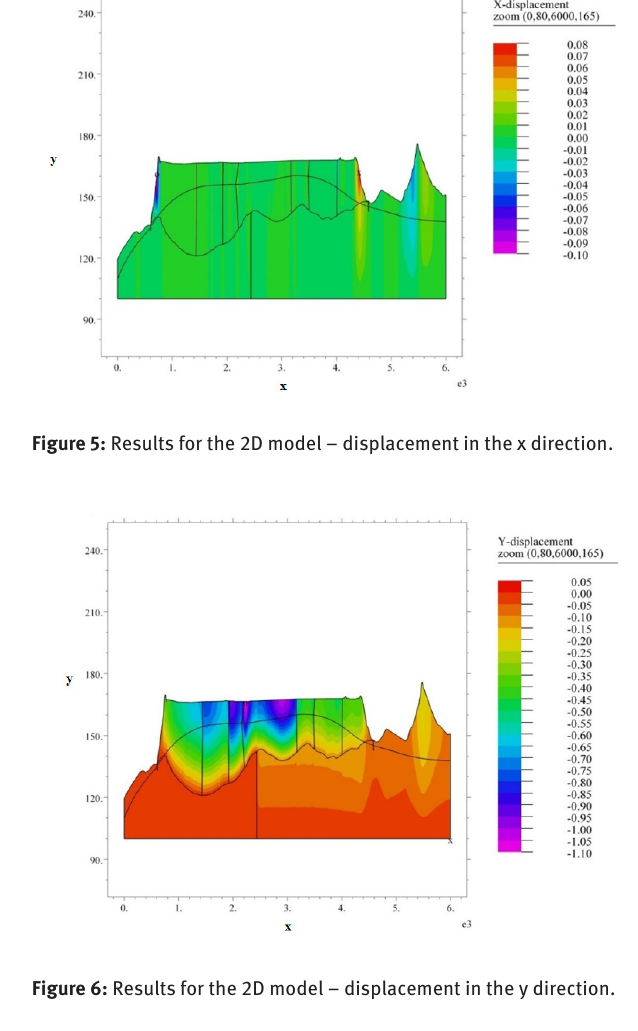
Figure 7: Results for the 2D model – stability